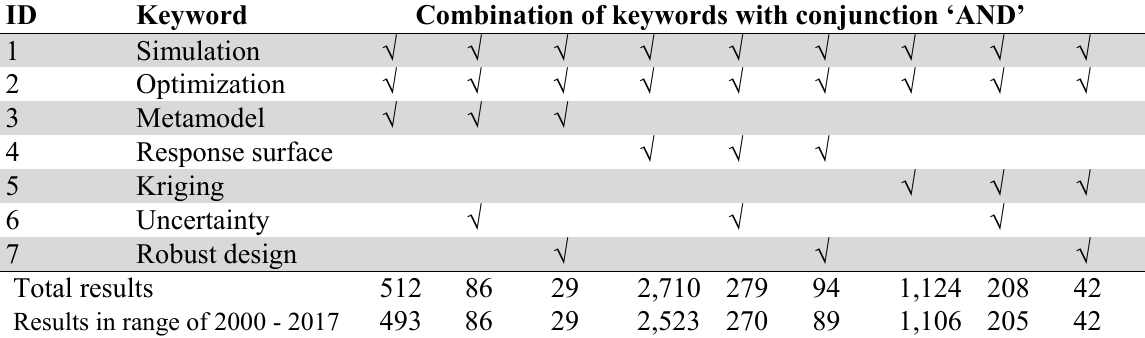
Number of document results based on combination of different keywords (Scopus